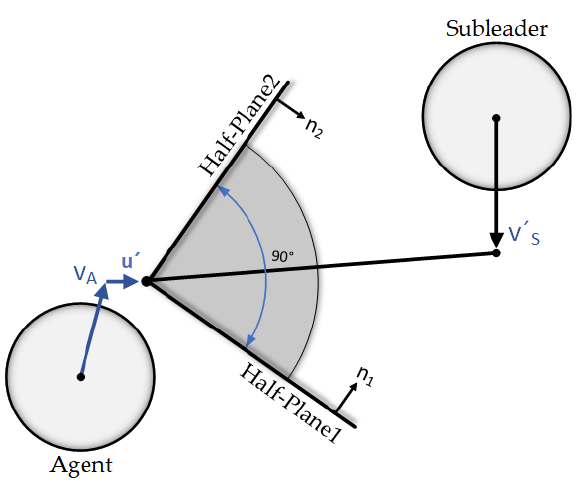
Figure 5. Producing additional half-planes in the direction of the subleader. V (cid:48) velocity of the